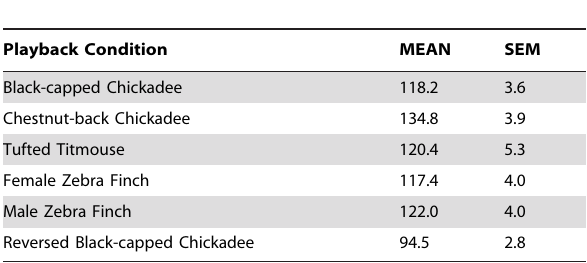
Table 2. Mean and Standard Error of the Mean of the Number of Positive ZENK Cells Across All Brain Regions for Playback